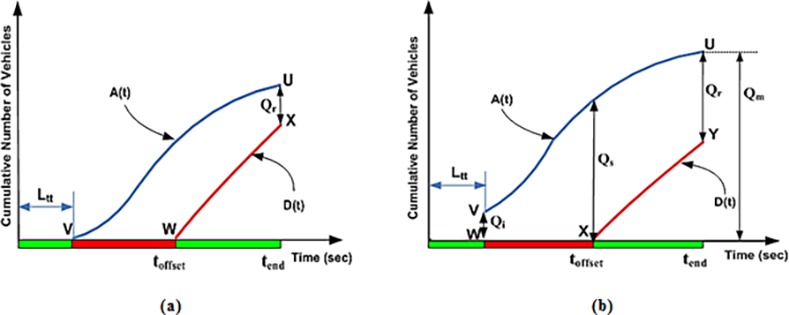
Input-output analytical technique.